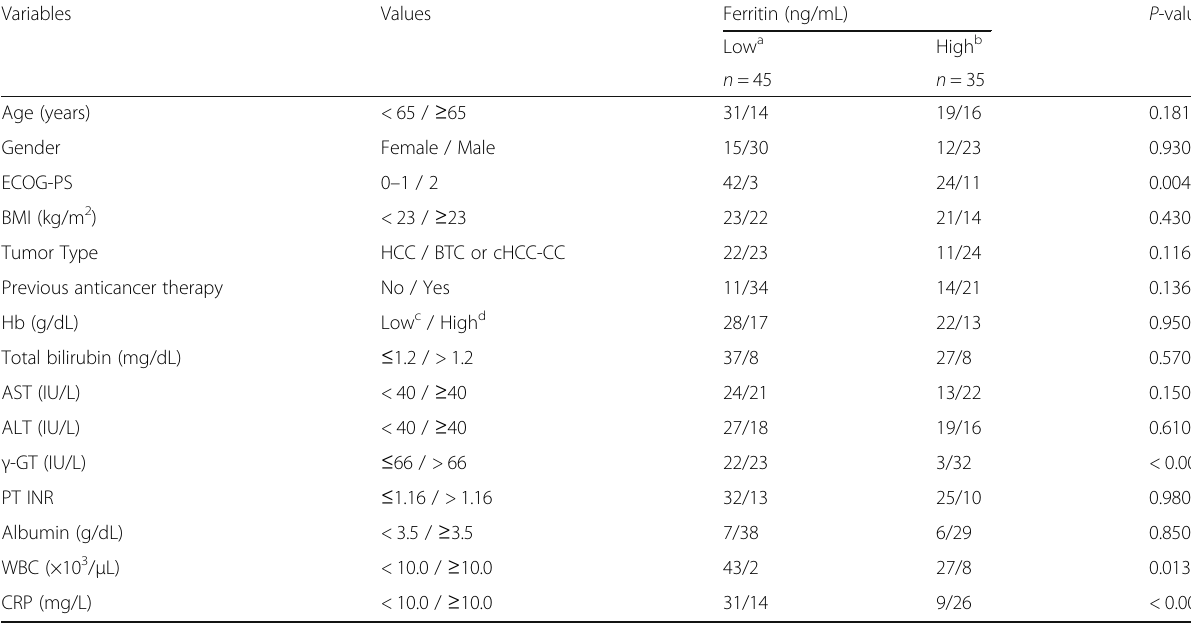
Table 2 Subgroup analysis according to serum ferritin level ( n = 80)